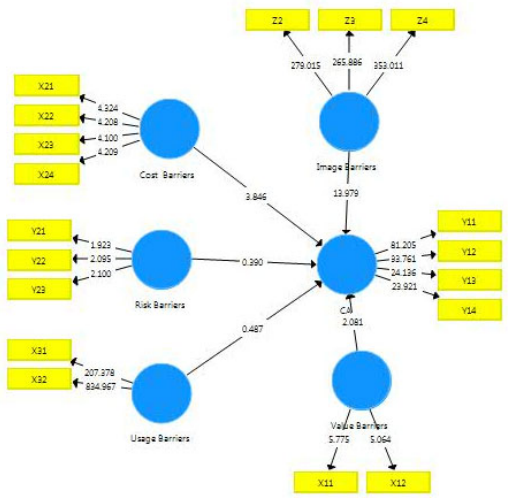
Fig. 3. Hypothesis